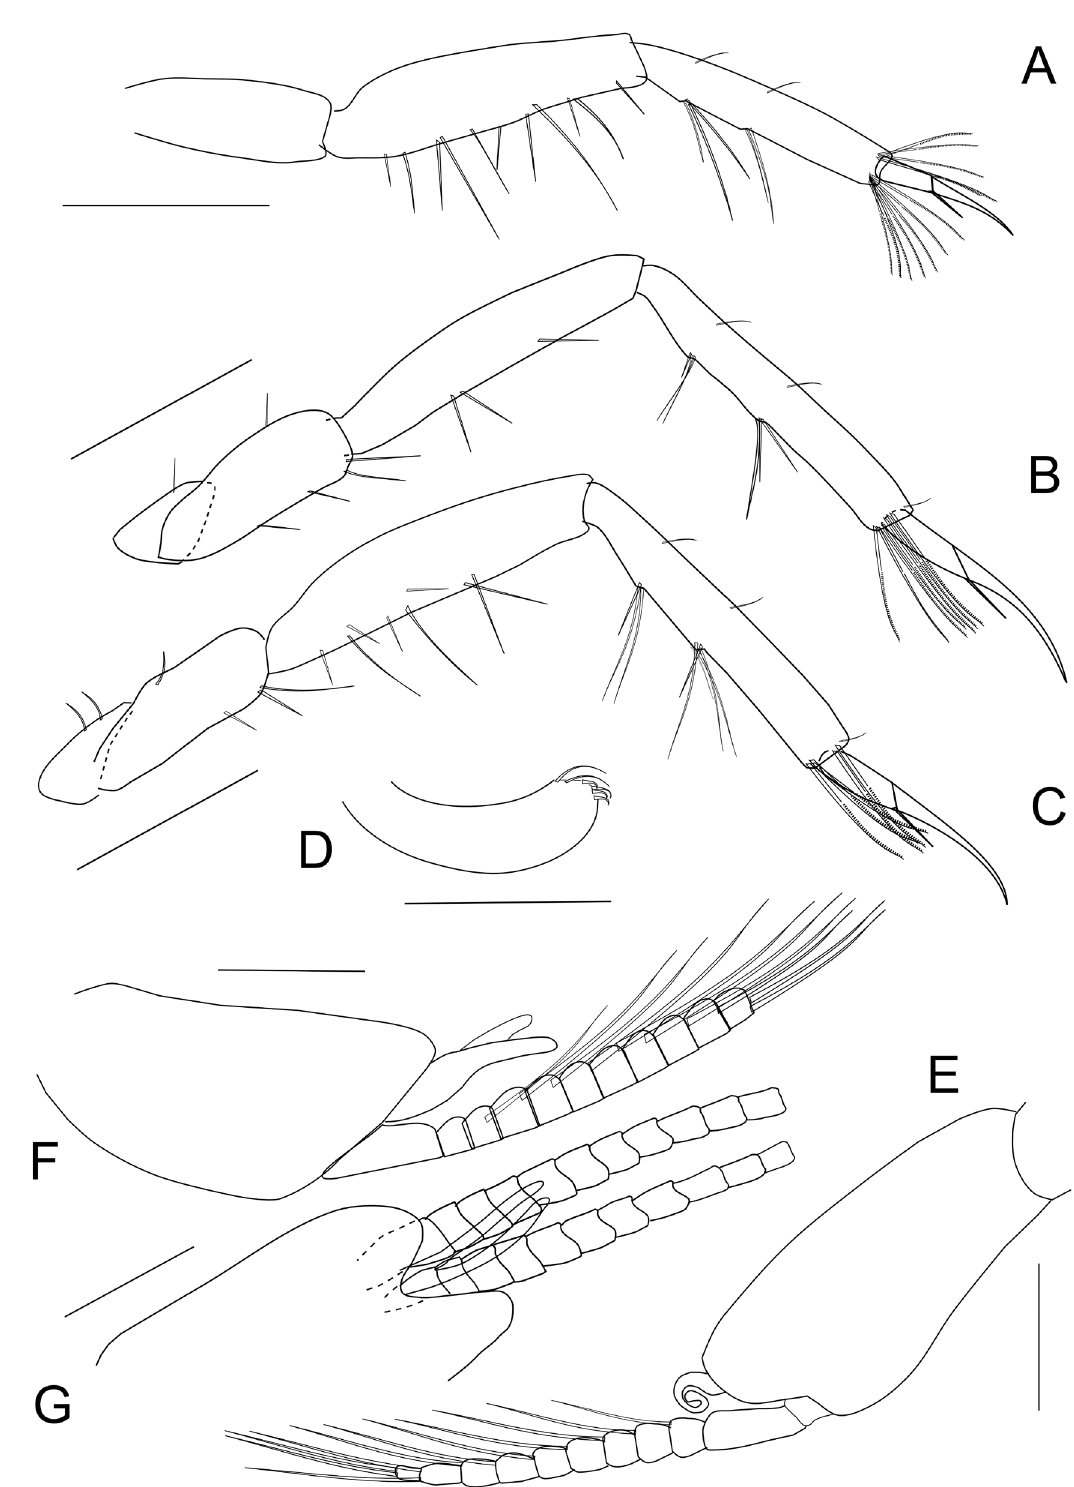
Fig. 17. Siriella muranoi sp. nov., holotype, ♂, length 5.5 mm, Port Essington, Arafura Sea, Northern Territory, Australia. A . Endopod of pereopod 4, posterior view. B . Endopod of pereopod 5, posterior view. C . Endopod of pereopod 6, posterior view. D . Penis. E . Pleopod 3 (endopod not shown), lateral view. F . Pleopod 5 (endopod not shown), lateral view. G . Pleopod 5 (rami setae not shown), anterior view. Scale bars: A–D = 0.5 mm; E–G = 0.2